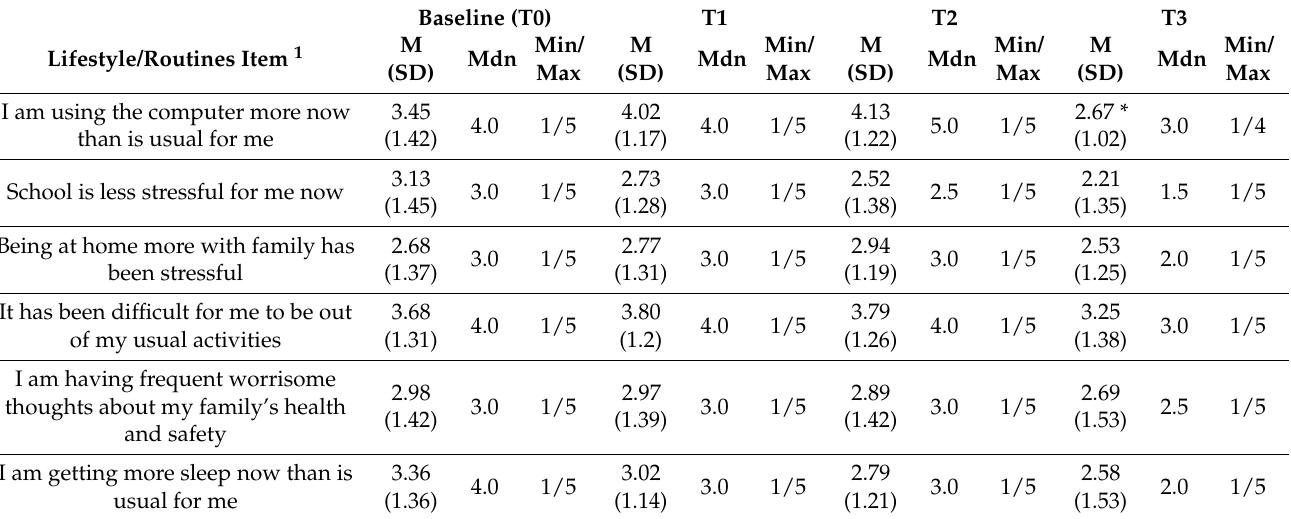
Table 1. Descriptive statistics on items about changes in routines and lifestyle by survey timepoint.